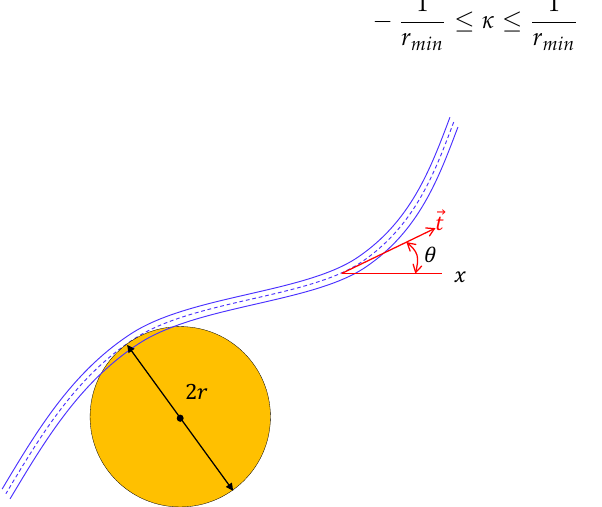
Figure 2. Curvature constraint for a towed tape reference line